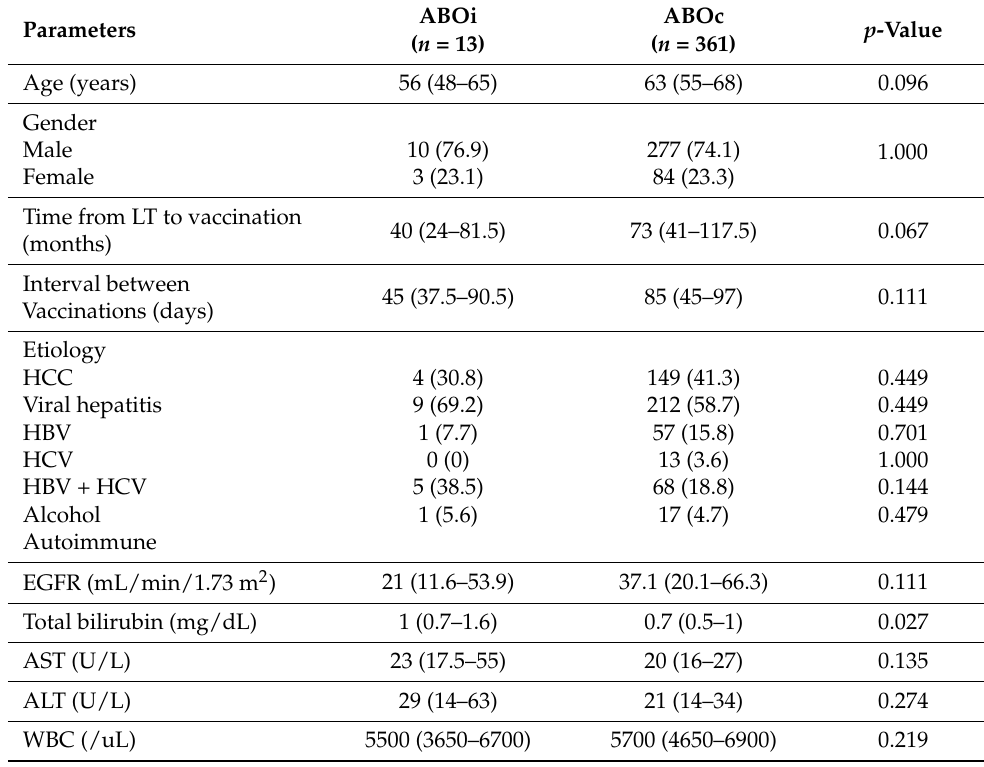
Table 4. Baseline characteristics of ABO incompatible